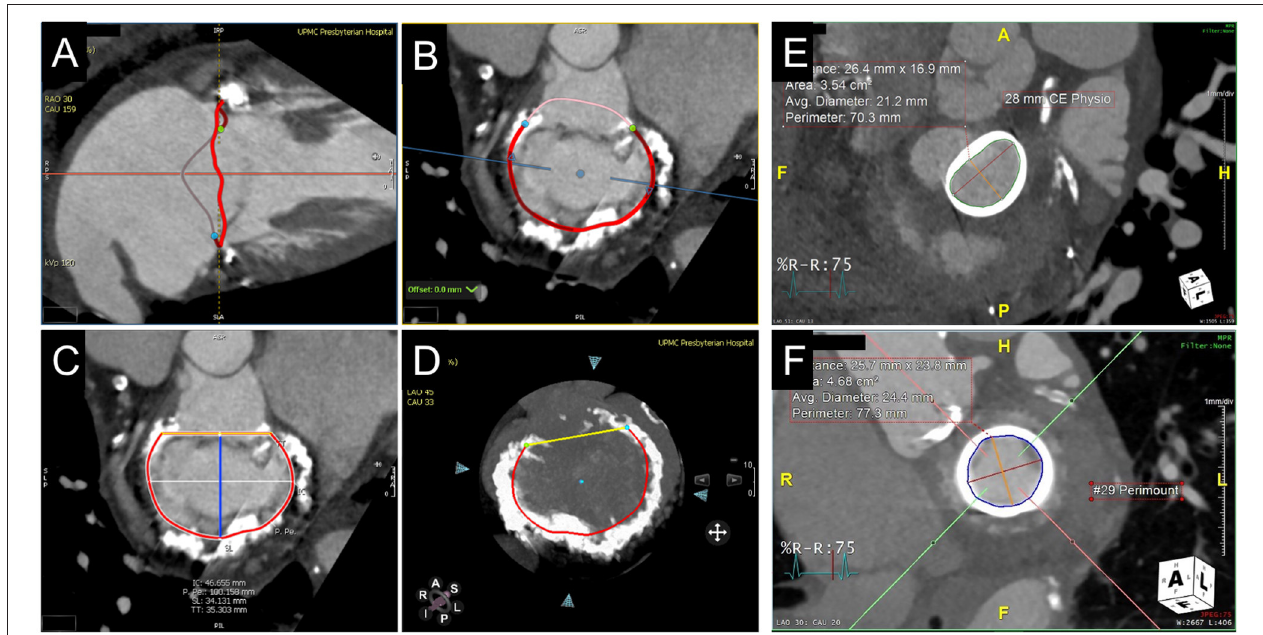
FIGURE 3 | CT annular segmentation for TMVR. (A–D) Segmentation of the native mitral annulus for the planning of valve-in-MAC TMVR. As shown from a long-axis view (A) , the mitral annulus outlined in red (A) has a non-planar saddle geometry. Projected into a short-axis view (B) , the anterior horn ( pink border ) may be truncated to assume a D-shaped configuration. (C) The trigone-trigone ( orange ), septal-lateral ( blue ), and inter-commissural ( white ) distances are measured from this view. Maximum intensity projection (D) allows for assessment of the distribution and density of annular calcification. (E) Valve-in-ring TMVR measurements of a complete semi-rigid ring with the major diameter in the inter-commissural dimension ( red ) and the minor diameter in the septal-lateral dimension ( orange ). (F) Valve-in-valve TMVR assessment showing the internal diameter slightly under the manufacturer specifications for the